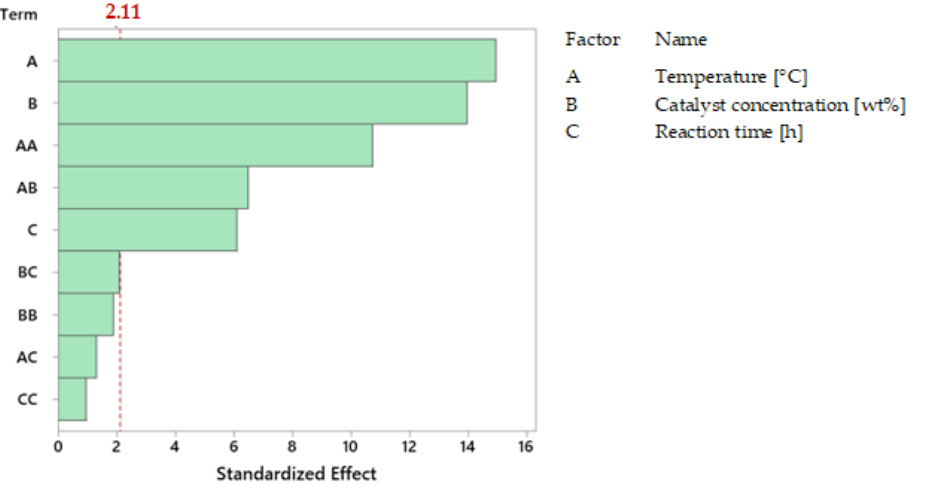
Figure 6. Pareto chart of standardized effects; response is GA (geraniol) conversion (mol%) ( α = 0.05).